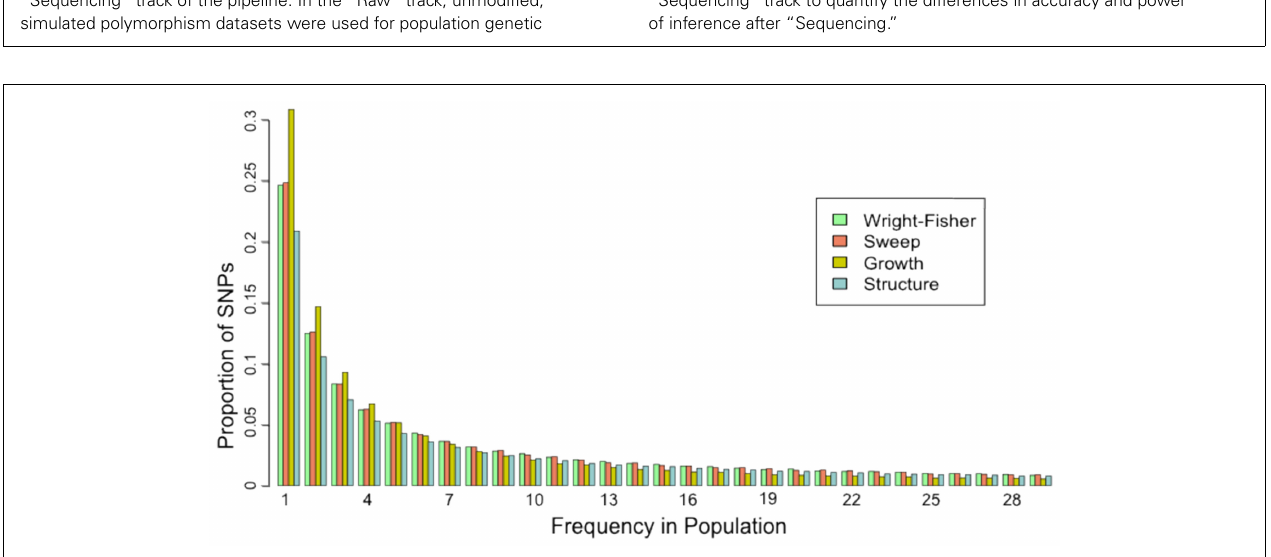
analysis. In the “Sequencing” track, simulated polymorphism datasets were processed through an in silico sequencing pipeline, and polymorphisms inferred from the “sequence” data were used for population genetic analysis. Comparisons were made between population genetic analysis results from the “Raw” track and the “Sequencing” track to quantify the differences in accuracy and power of inference after “Sequencing.”